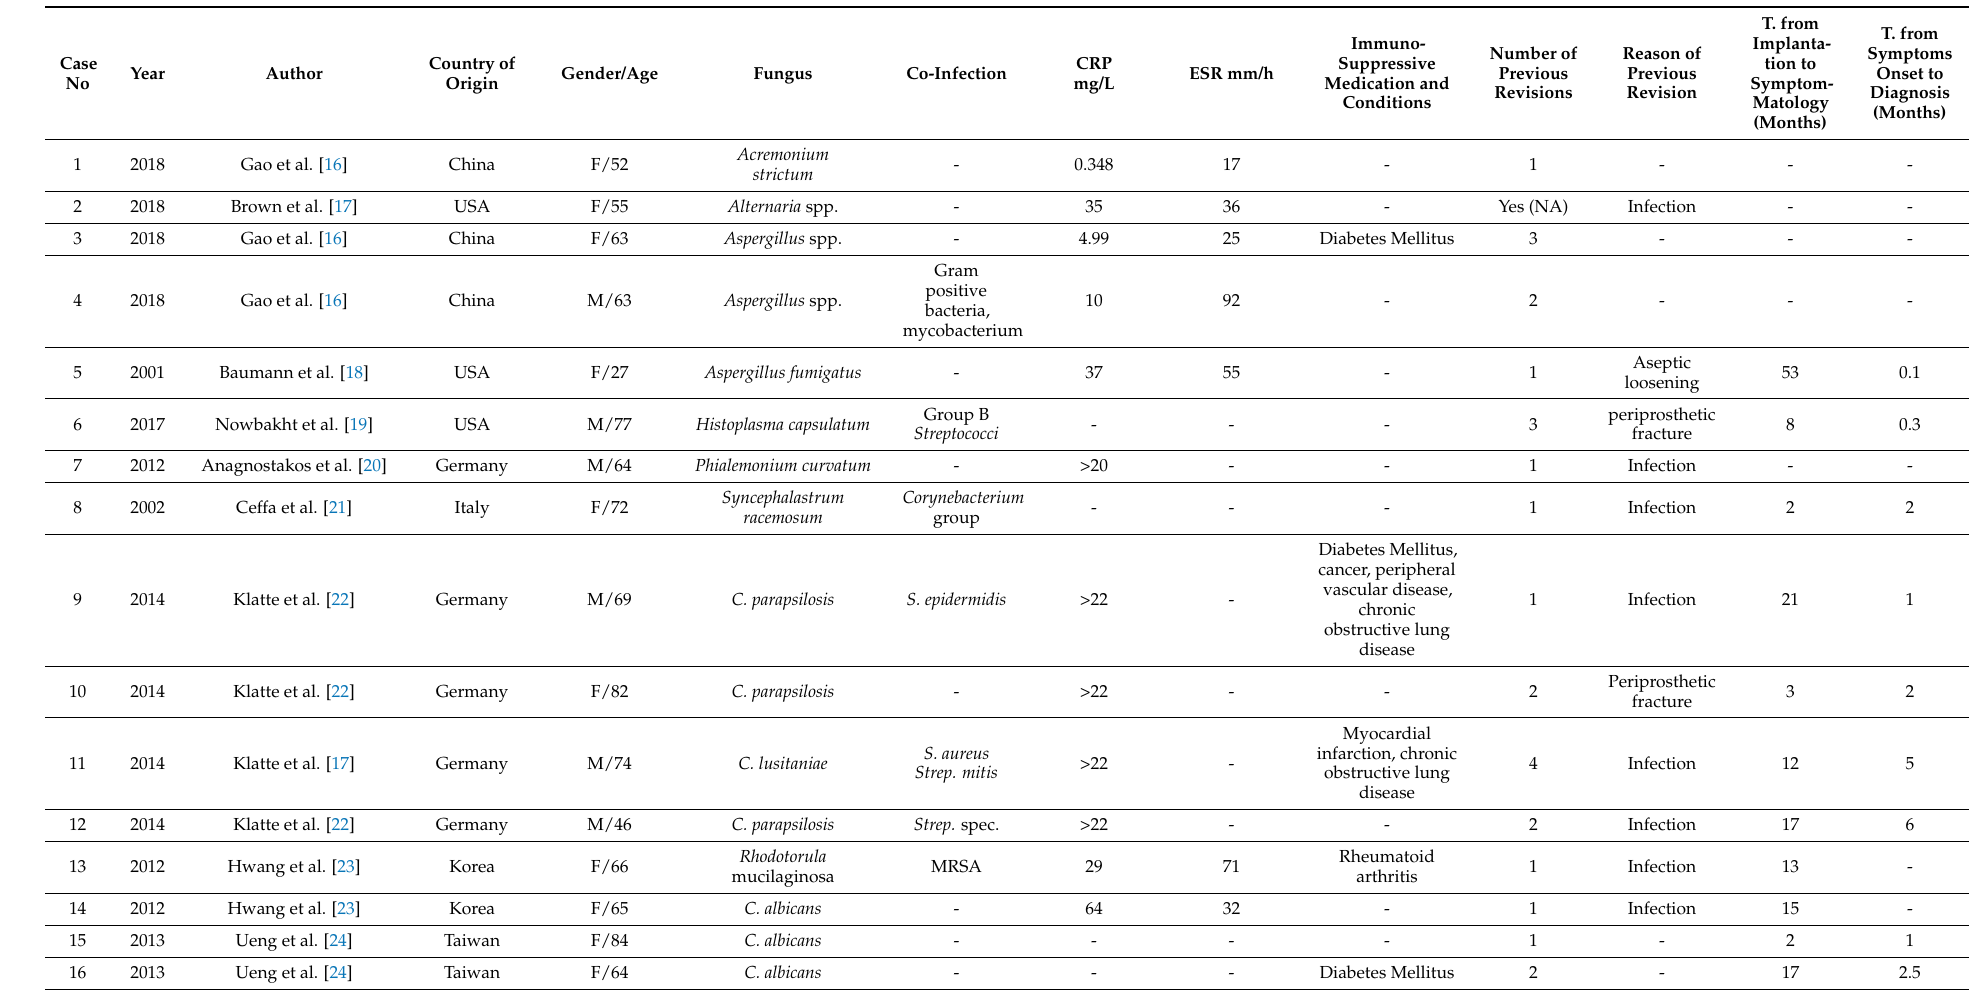
Table 1. Patients’ demographics, comorbidities, responsible fungus, affected joint, bacterial co-infection, time (T) interval from joint implantation to symptom onset and from symptom to diagnosis, number of previous revisions in the same joint, c-reactive protein, (CRP), and Erythrocyte Sedimentation Rate (ESR) at presentation. (-): Not mentioned in the original